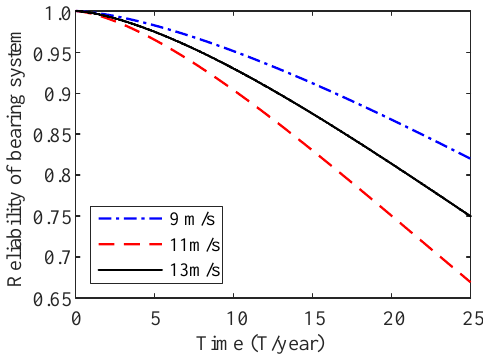
Figure 13. Reliability of bearing system with different average wind speed.